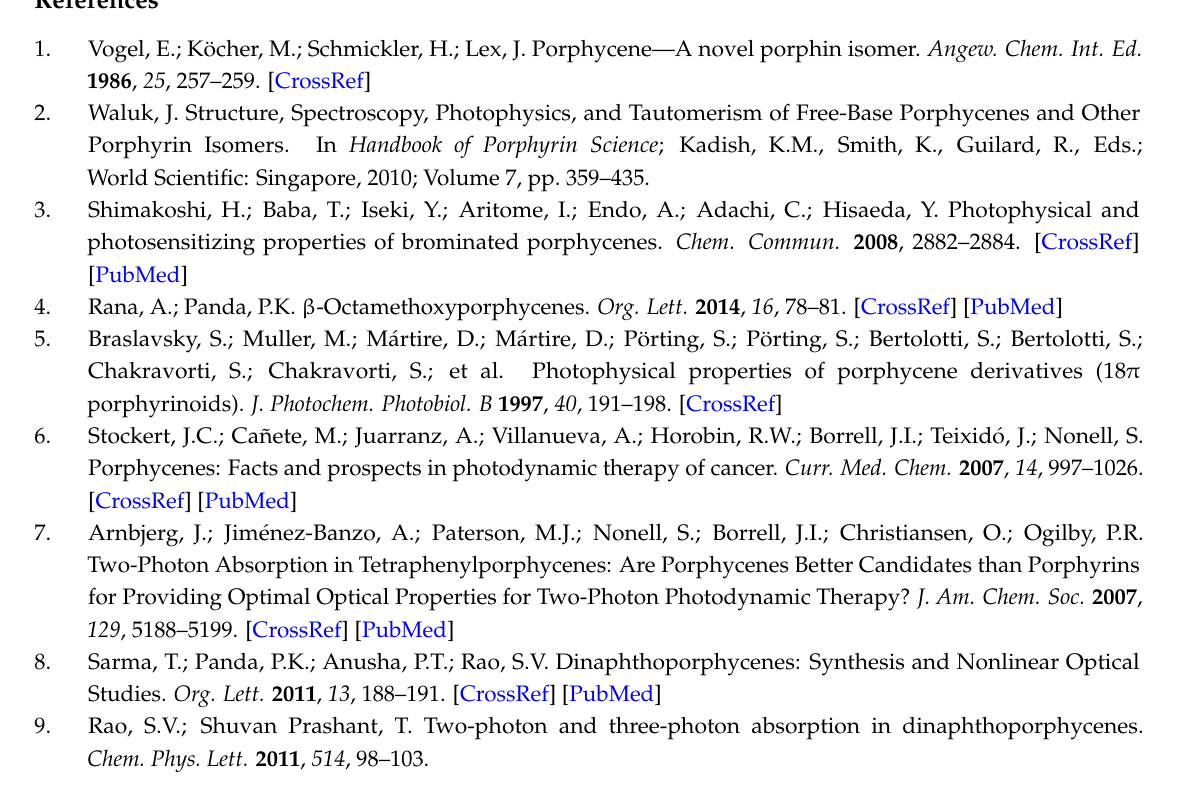
Supplementary Materials: The following are available online: Table S1 and S2, and Figure S1: Crystal data of 2a and 2b ; Figure S2 and S3: H-H COSY and NOE spectra of 1a-H 2 ; Figure S4 and S5: Changing of the absorption spectra of THPc and THPc-Ni upon addition of